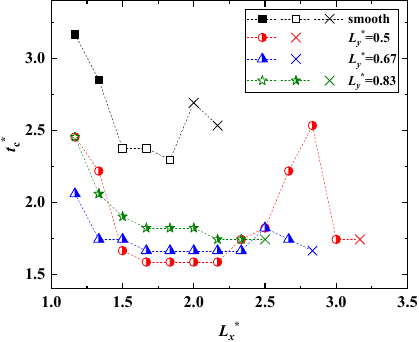
Figure 10. The variations of the contact time with L x * at various L y * on the S1 surface.